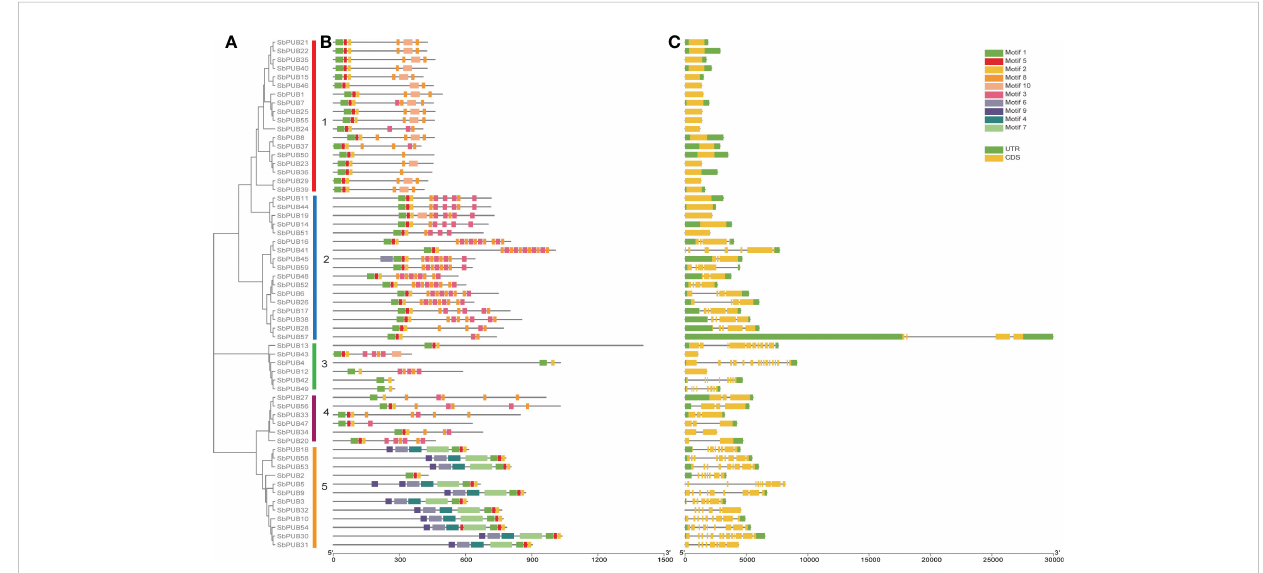
FIGURE 1 The phylogenetics, conserved motifs, and gene structure analysis of SbPUB proteins. (A) The Neighbor-Joining (NJ) phylogenetic tree of 59 sorghum PUB genes. Different colors of the branches represent fi ve groups with marking in Latin letters. (B) The conserved motifs analysis of PUB genes in sorghum. Ten different motifs were predicted by MEME software, with the scale bar at the bottom. (C) The gene structure analysis of SbPUB genes using the tool of GSDS, including intron (grey lines), UTR (green rectangles), and exon (orange